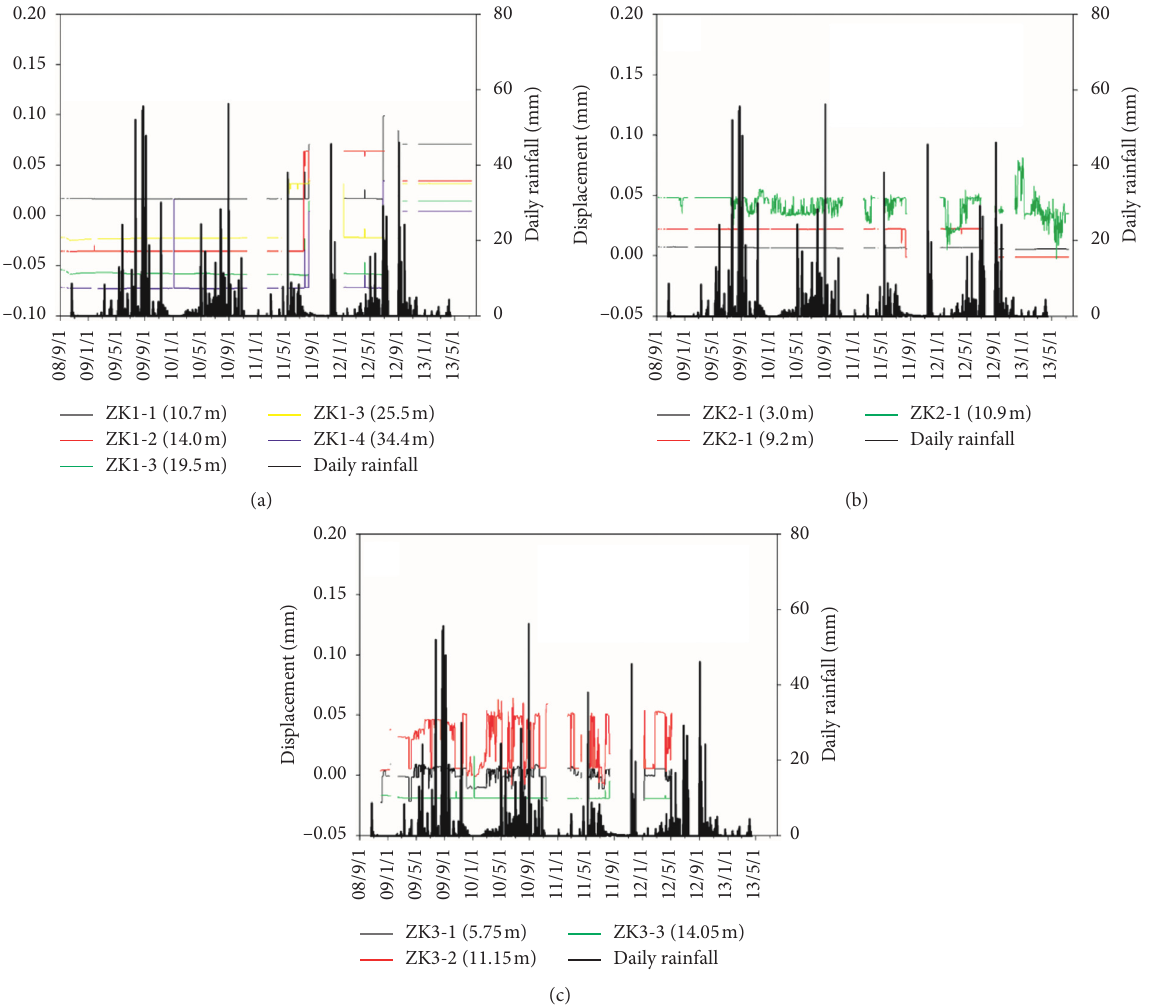
Figure 10: Relationship between daily landslide displacement and daily rainfall: (a) ZK1; (b) ZK2; (c)